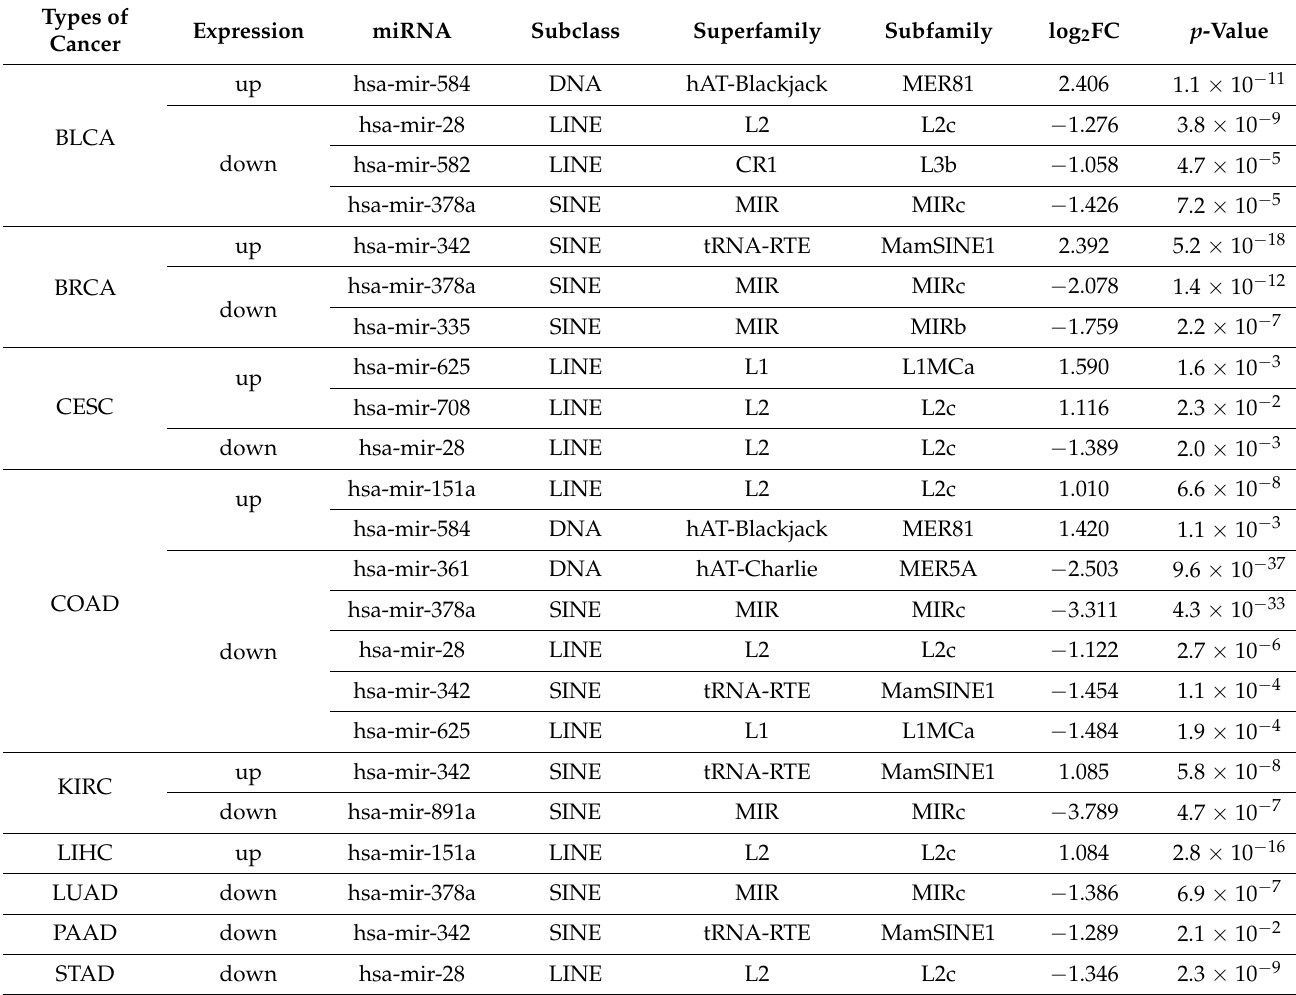
Table 3. Differentially expressed miRNAs in the tissue of each of 9 types of cancer obtained from the TCGA